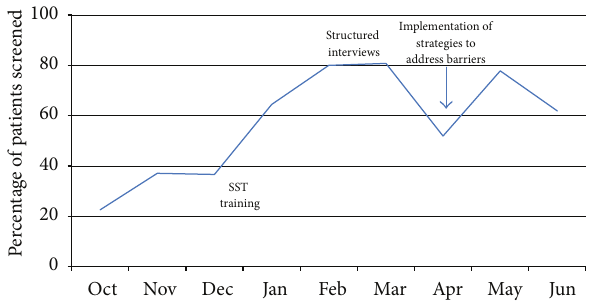
Figure 1: Percentage of patients screened in the emergency depart- ment from October 2009 to June 2010.